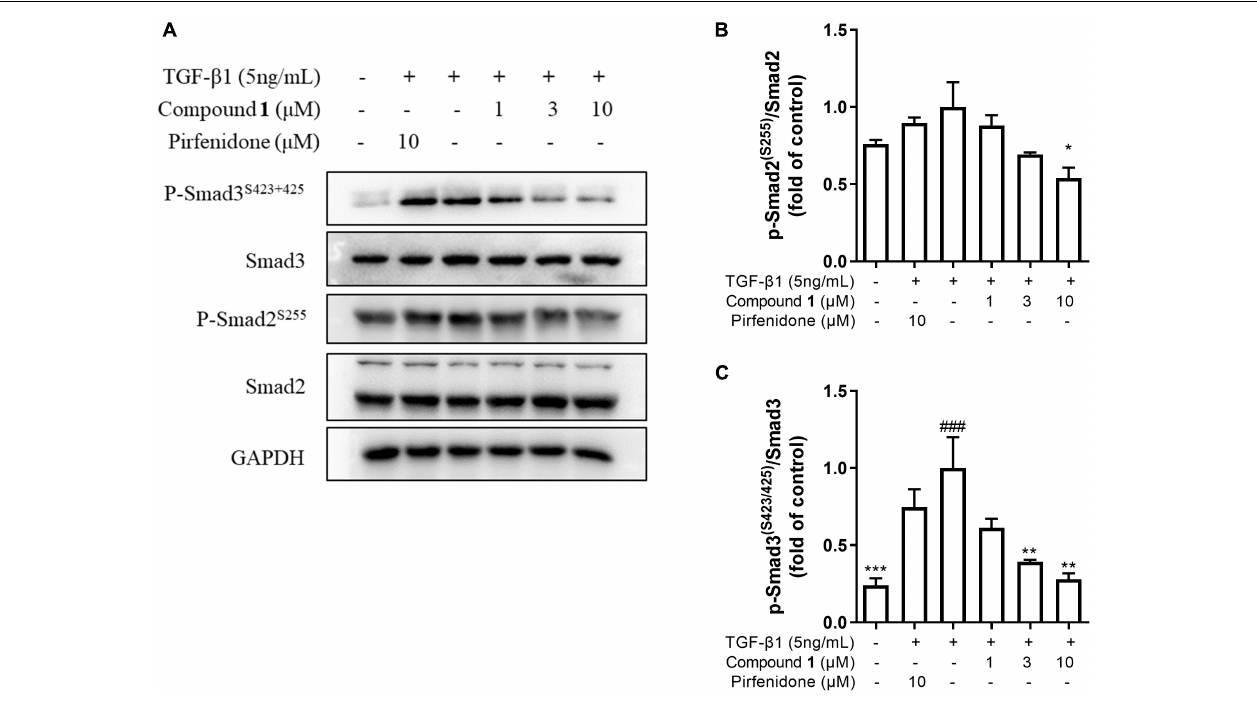
FIGURE 5 | Effect of trichocarboline A ( 1 ) on Smad signaling pathway. (A–C) HFL1 cells were treated with various concentrations of compound 1 (0, 1, 3, 10 µ M) or pirfenidone in the presence or absence of transforming growth factor TGF- β 1 (5 ng/mL) stimulation for 30 min. The protein expression of (B) p-Smad2 Ser255 , and (C) p-Smad3 Ser423 / 425 was analyzed by Western blotting. n = 3. Data were presented as the mean ± SEM. * P < 0.05, ** P < 0.01, *** P < 0.001 vs. the TGF- β 1 group. # P < 0.05, ## P < 0.01, ### P < 0.001 vs. the control group.